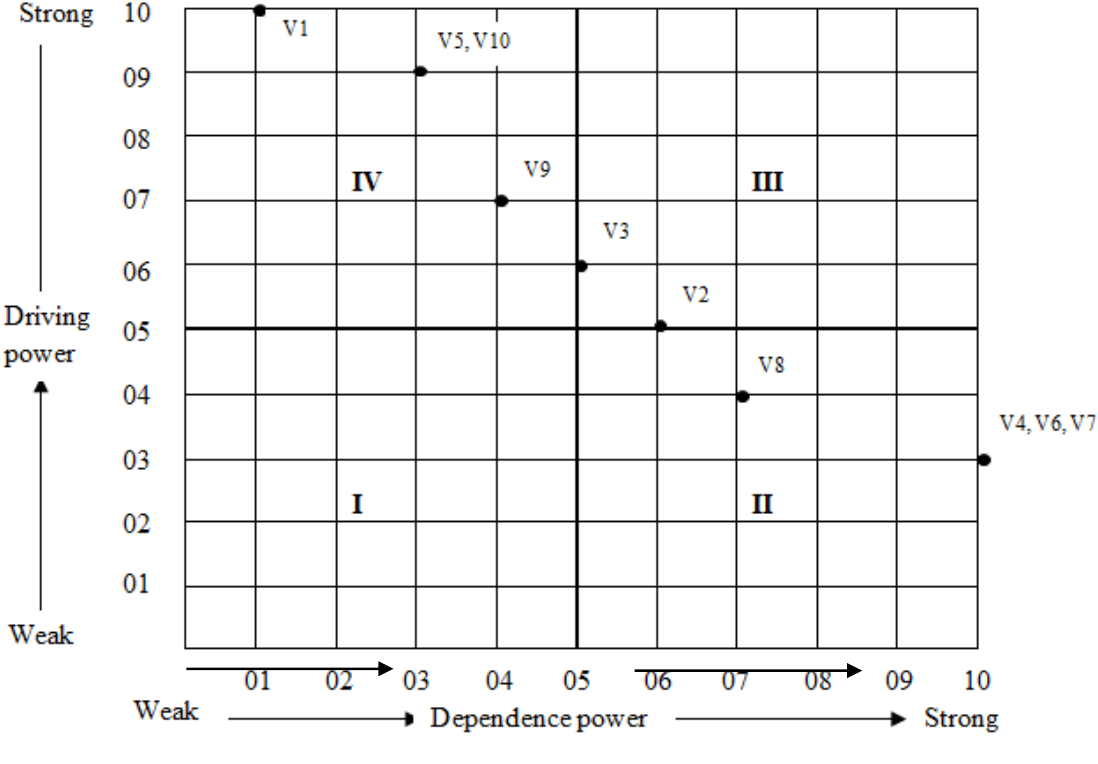
Figure 2: Driving power and dependence